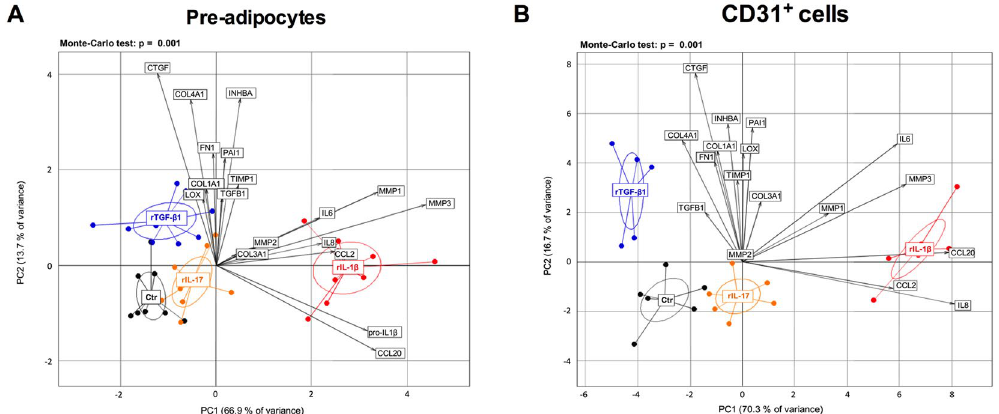
Figure 3. Cytokine-specific effect on fibrotic and inflammatory genes. Principal components analysis (PCA) plots of fibrotic and inflammatory genes in pre-adipocytes ( A ) and CD31 + endothelial cells ( B ) treated or not by rIL-17 (10 ng/mL), rIL-1 β (10 ng/mL) or rTGF- β 1 (5 ng/mL). Points represent individual cell cultures in untreated control (Ctr) or cytokine-treated conditions as indicated. Groups are identified by color and circled with a median elliptical centroid. Arrows depict the contribution of each gene to sample coordinates. P values were obtained by Monte Carlo rank